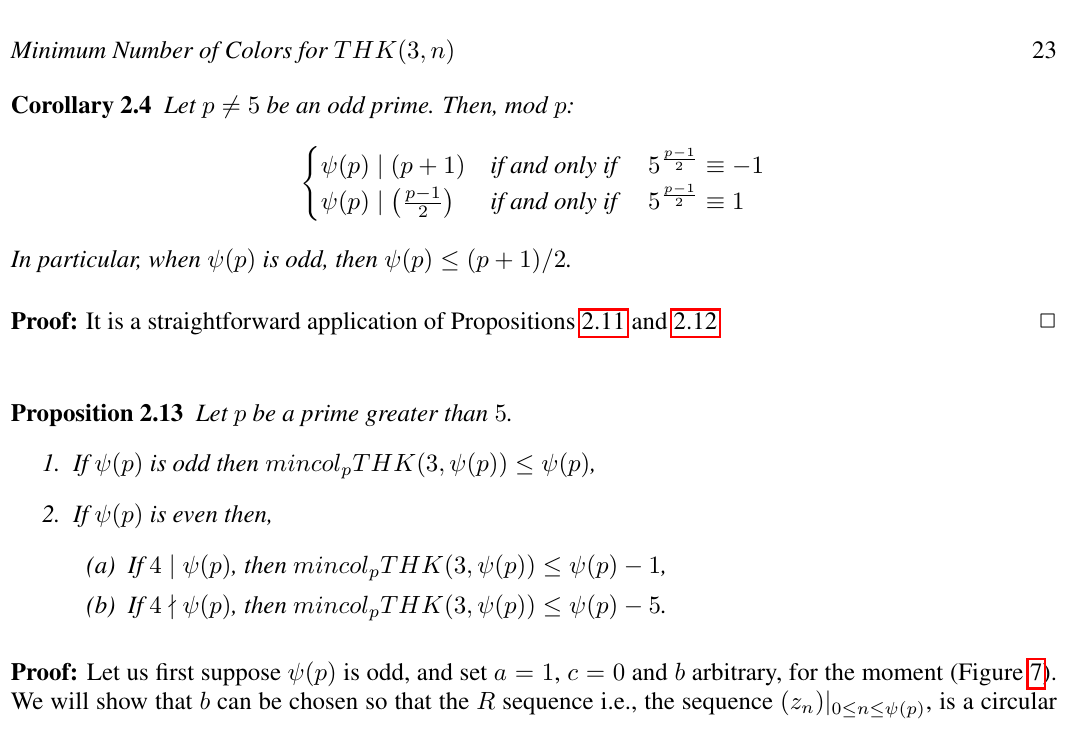
for a particular choice of a, b, c 1